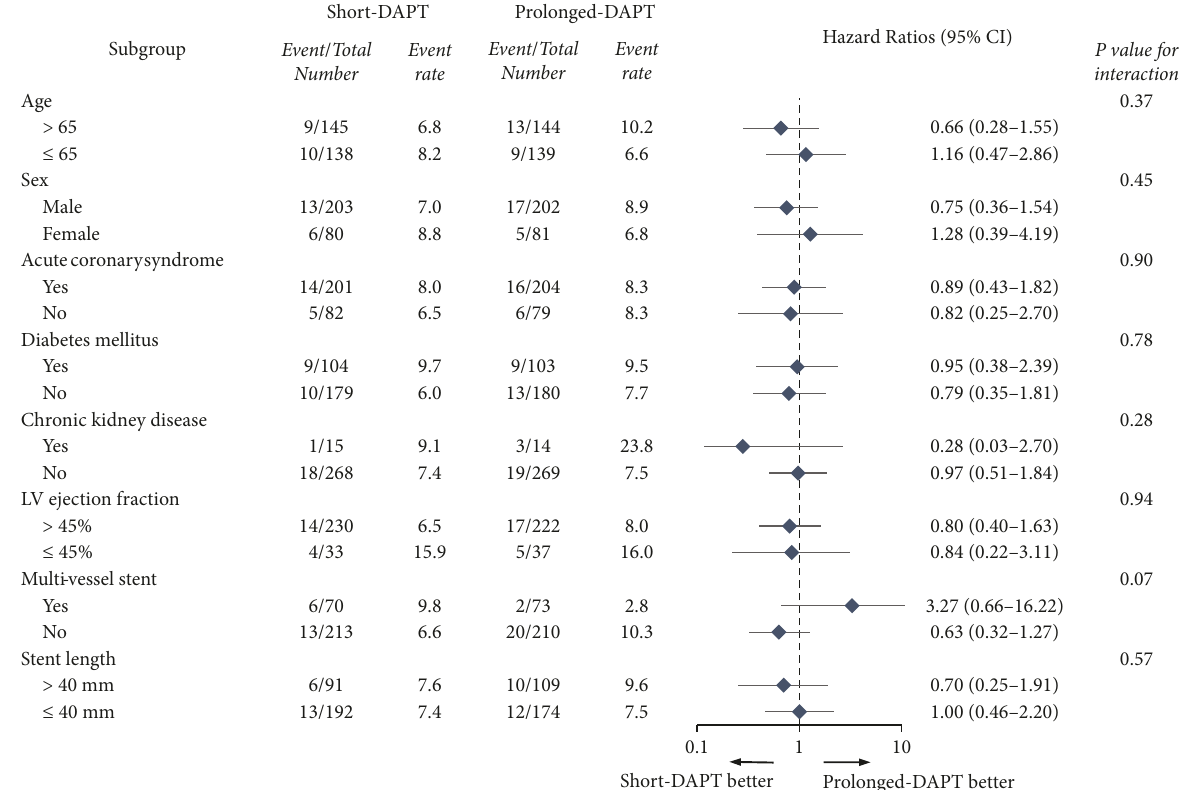
Figure 2: Subgroup analysis for the primary endpoint in the matched population. DAPT, dual antiplatelet therapy; LV, left